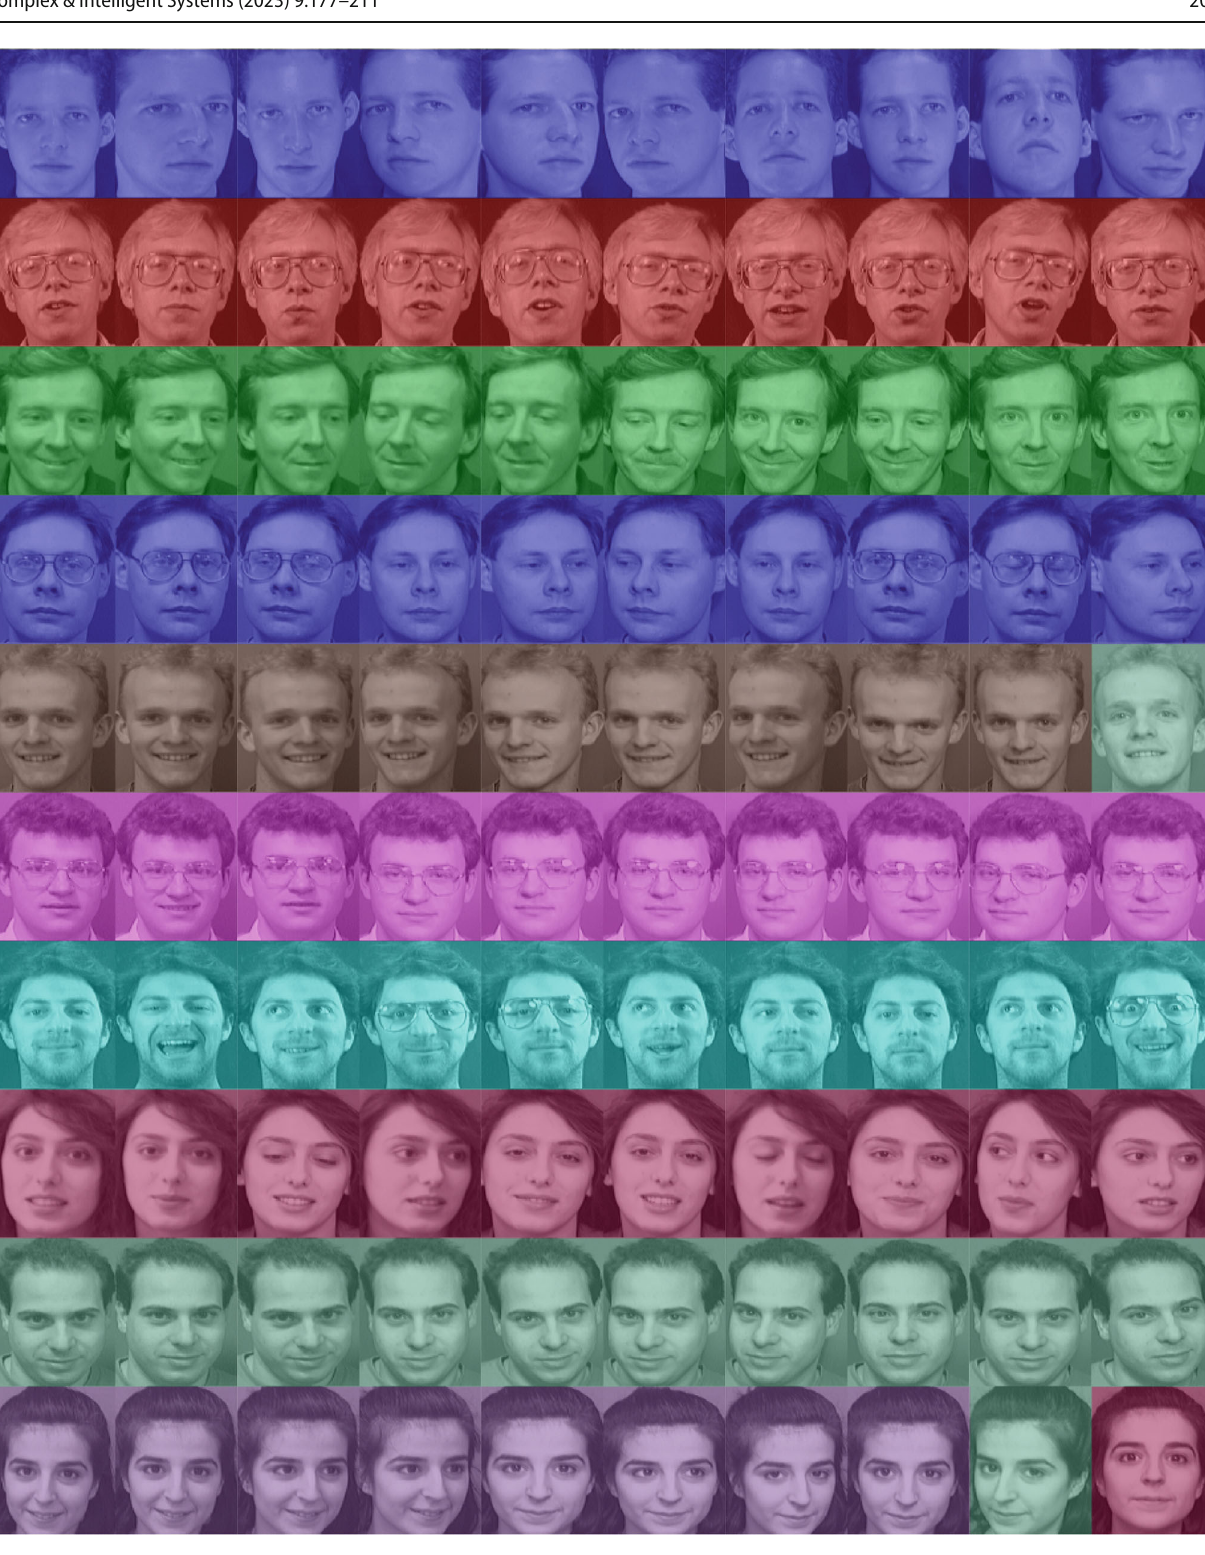
Fig. 14 AmDPC algorithm processing Olivetti Face dataset visualization